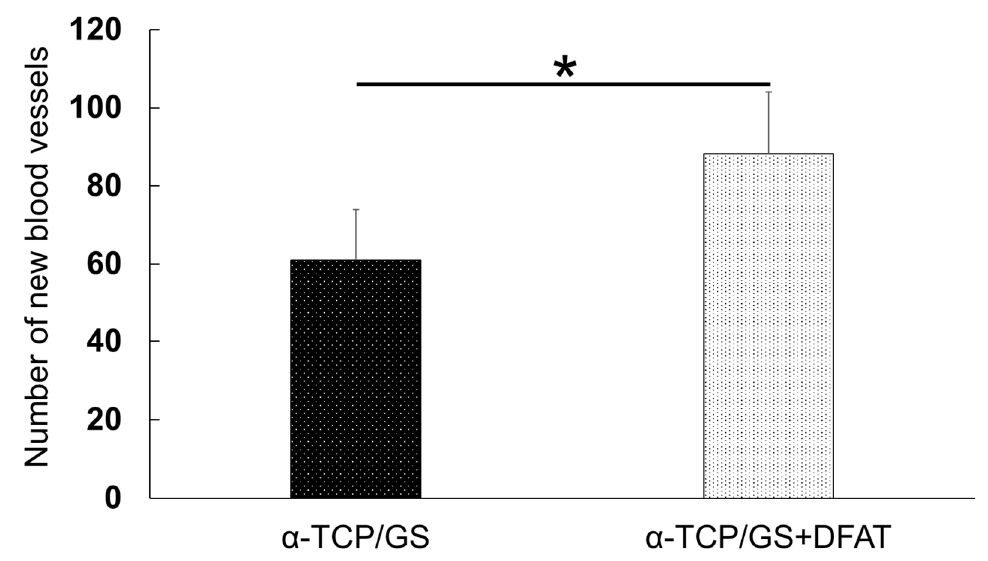
Figure 17. Results of the analysis of the number of new blood vessels; Student’s t -test; * p < 0.05; n = 4.